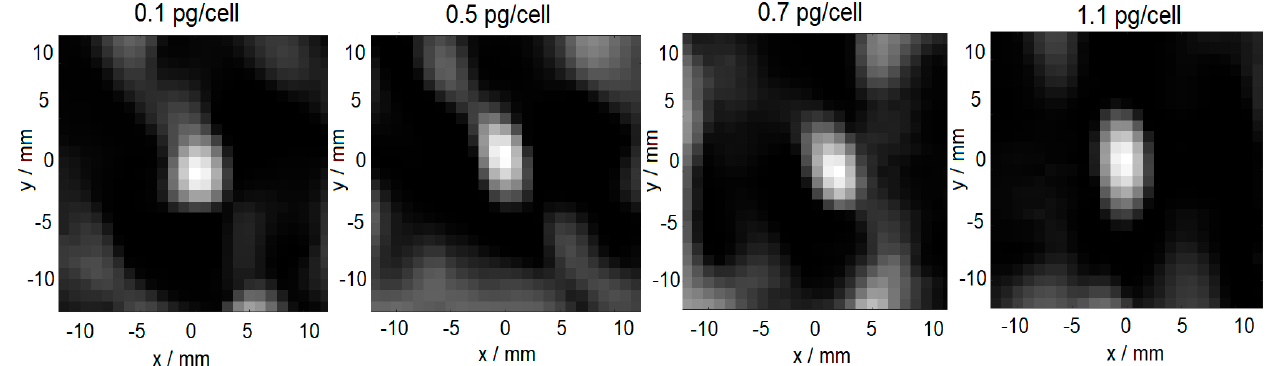
Figure 8. Reconstructed MPI images of THP − 1 monocytes loaded with different amounts of Syn-COOH ( m (Fe) = from 0.05 to 1.1 pg/cell).